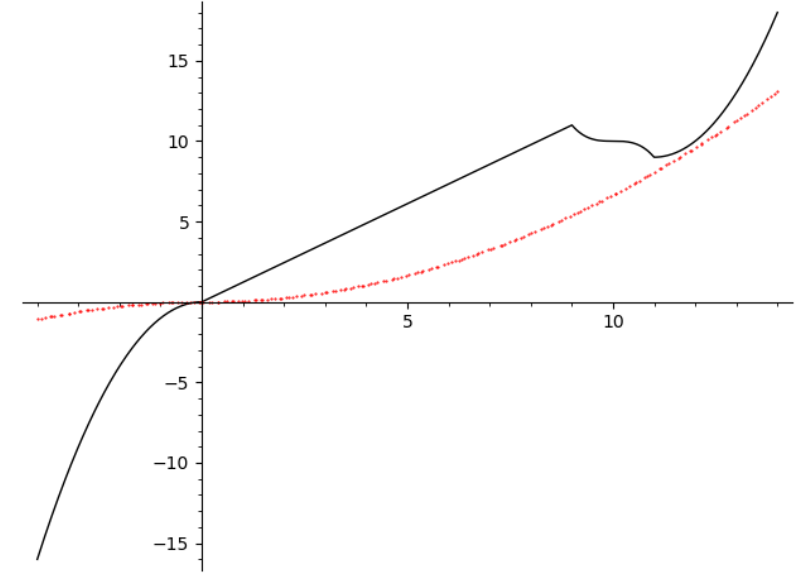
Fig. 1: f ( t ) in continuous line, c | t | q −1 t in dotted